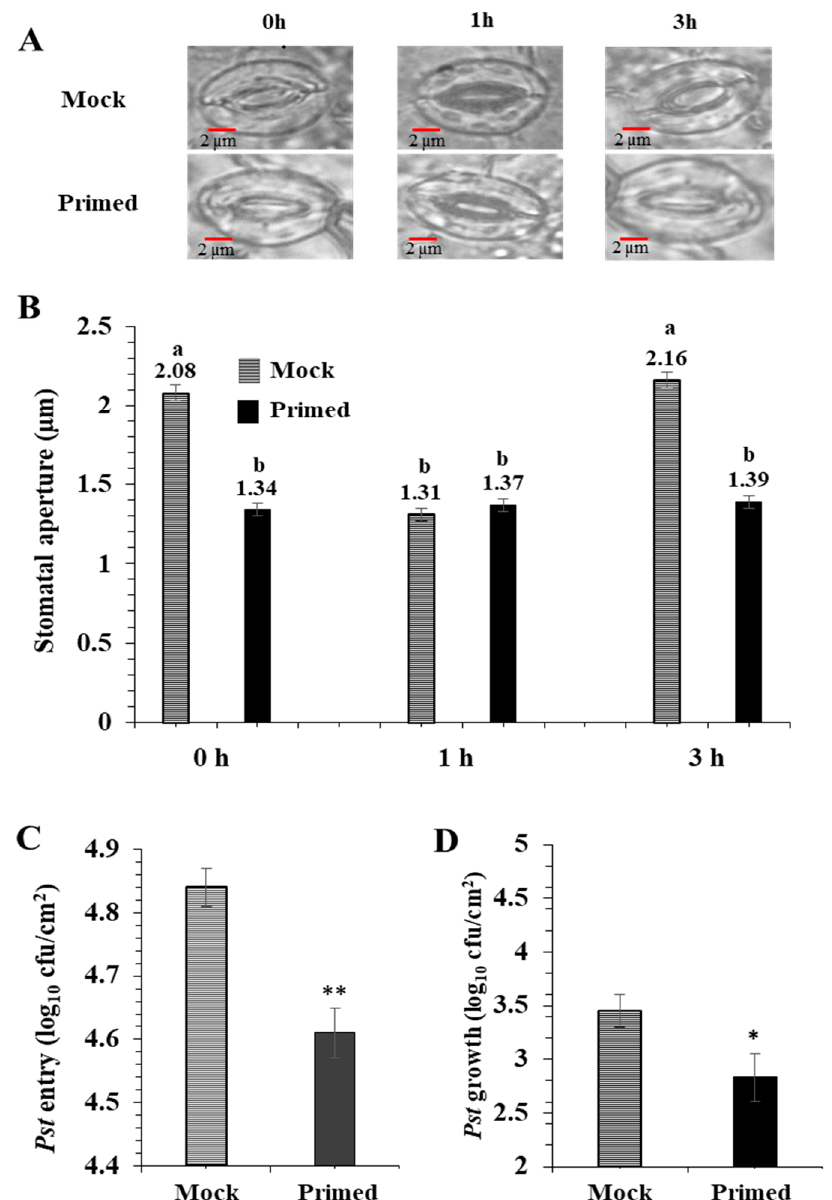
Figure 1. Pathogen entry and growth assays revealed enhanced stomatal immunity in primed Arabidopsis leaves. ( A ) Images showing representative stomatal apertures in mock and primed Arabidopsis leaves after 0, 1, and 3 h after secondary exposure to Pst DC3000. ( B ) Quantitative measurements of 150 stomata from three replicate experiments. Statistically significant differences were marked by a and b. ( C ) Pst DC 3000 entry results obtained from nine biological replicates of primed and mock plants. The data are presented as average ± standard error. ( D ) Pst DC 3000 growth results obtained from nine biological replicates of primed and mock plants. The data are presented as average ± standard error. ** p < 0.01, * p <